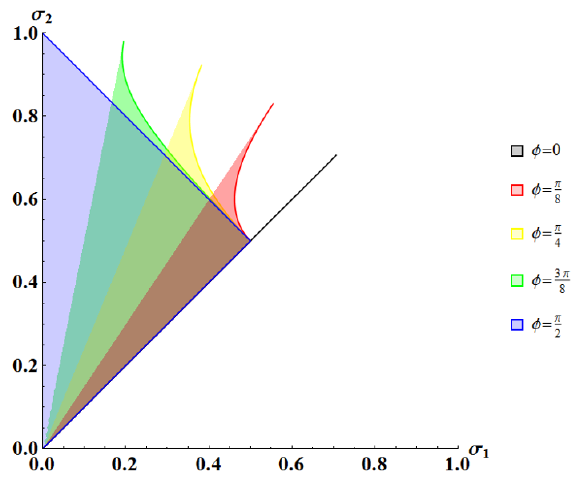
Figure 2 . (cid:30) (cid:17) arg (cid:11) (cid:0) arg (cid:12) dependence of (cid:27) 1 and (cid:27) 2 in the case with two isometries gauged. As the parameters j (cid:11) j and j (cid:12) j , we change them under 0 (cid:20) j (cid:11) j ; j (cid:12) j (cid:20) 0 : 5. where (cid:30) (cid:17) arg (cid:11) (cid:0) arg (cid:12) . The (cid:12)gure 2 shows the parametric plot in ( (cid:27) 0 (cid:20) j (cid:11) j ; j (cid:12) j (cid:20) 0 : 5 with (cid:12)xed (cid:30) = f 0 ; (cid:25) scales. As (cid:30) approaches to (cid:25)= 2, the breaking scales can be hierarchical and the N = 1 (partial breaking) can be covered when (cid:30) = (cid:25)=